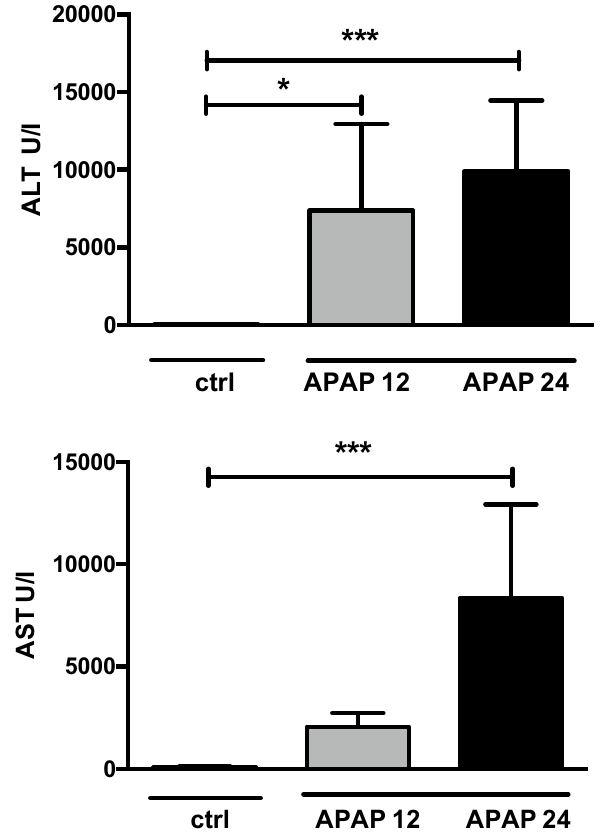
Figure 1. Serum levels of liver enzymes: alanine amino-transferase (ALT, upper panel) and aspartate aminotransferase activity (AST, lower panel) 12 h (APAP12) and 24 h (APAP24) after administration of N-acetyl-para-amino phenol (APAP) compared to controls (ctrl). The increase in liver enzymes indicated severe liver injury during the experiment. Values are mean and standard deviation expressed in U/l. * and *** indicate significance p < 0.001 or p < 0.0001